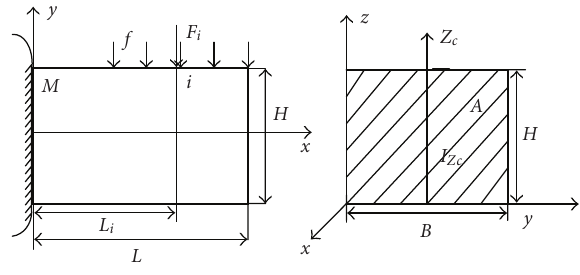
Figure 1: Deformation of single